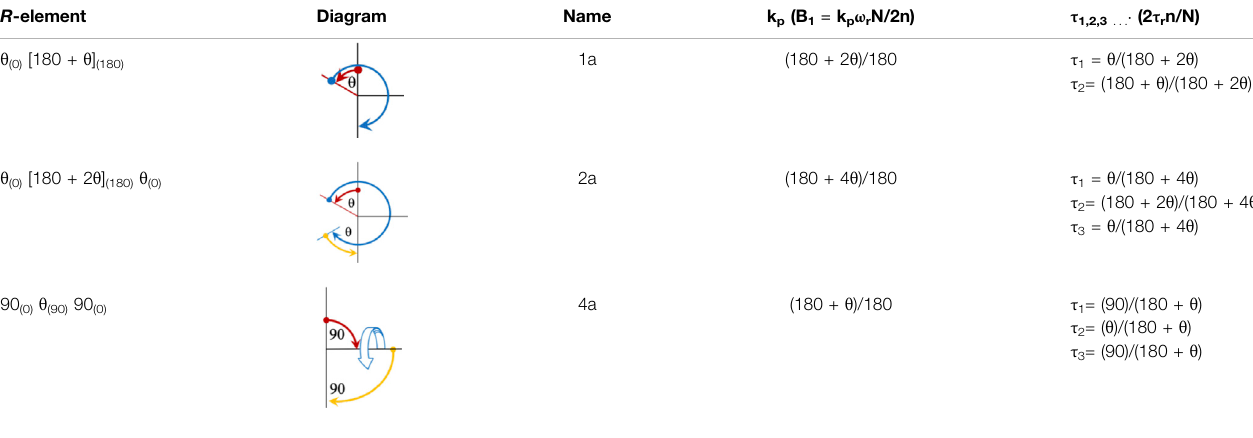
TABLE1| Selectedvariable fl ipangle R -elements,with fi eldandtimingdependencies.Redarrowsrepresentthe fi rstportionofthecompositepulse τ 1 ,blueisthesecond, τ 2 , and yellow is the third portion, τ 3 . R -element